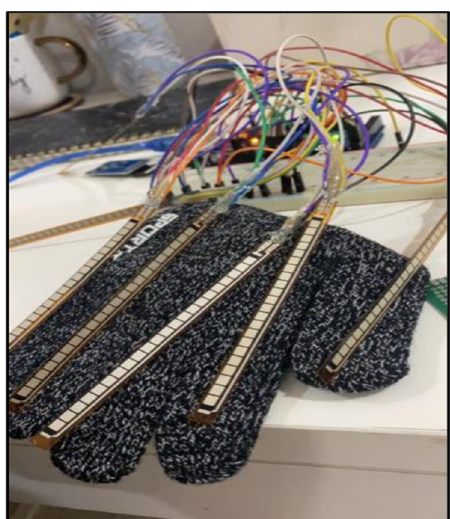
Figure 2: Gloves with